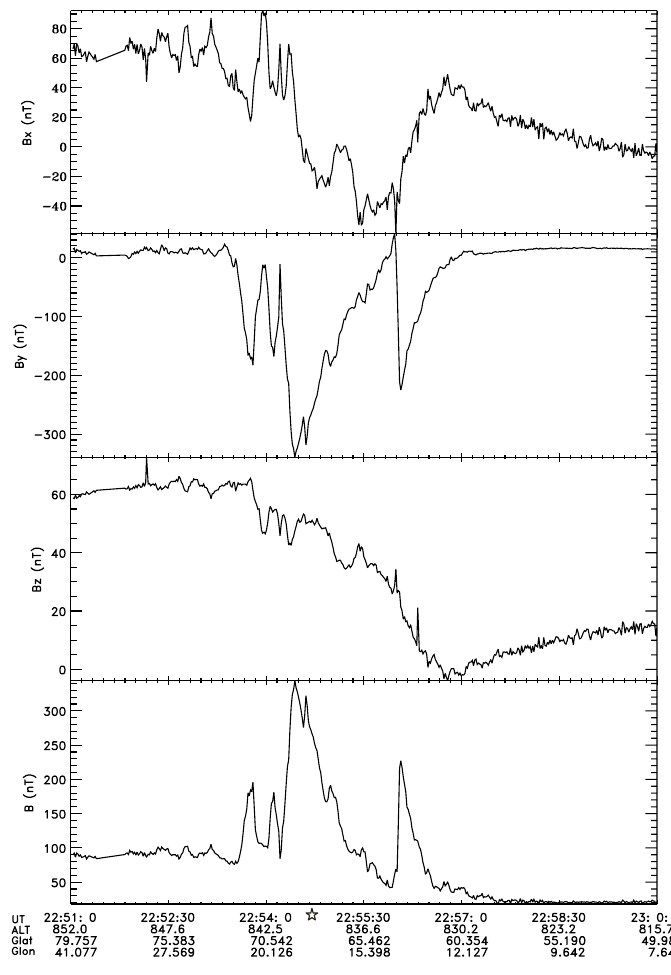
Fig. 8. Magnetic field measurements obtained by the flux-gate magnetome- ter carried on the Ørsted satellite. B x , B y , B z and B are shown after sub- traction of the preliminary Ørsted main field model, where X is positive geo- graphic north, Y is positive east, Z is positive down, and B is the total mag- netic field strength. The closest position of the EISCAT radar is indicated by the